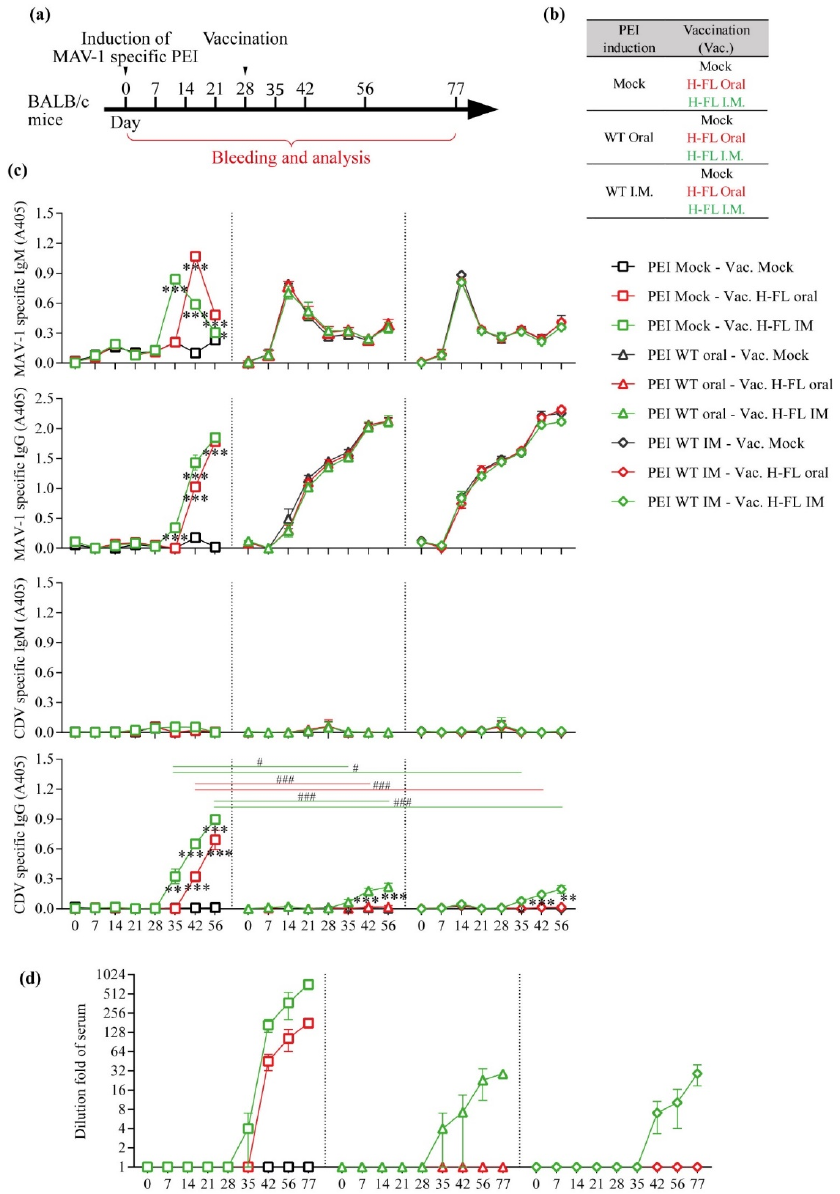
Figure 5. Effect of pre-existing immunity on primary vaccination efficiency. ( a , b ) Design of the experiment. Anti-MAV-1 specific pre-existing immunity was induced in 8-week-old female BALB/c mice ( n = 5 mice/group) through oral or intramuscular infection with 2000 TCID50 of MAV-1 WT as described in the methods. Mice were then immunized, or not, with 2000 TCID50 of the H-FL MAV- 1 strain at day 28 via the oral or the intramuscular route. Blood samples were taken at the indicated time points. ( c ) MAV-1 and CDV specific IgG and IgM measured over time in mouse serum as de- scribed in the methods. The different routes to induce pre-existing immunity are represented by symbols (mock: □ ; oral: △ ; IM: ◇ ) and the different routes of vaccination with the H-FL strain of MAV-1 are labeled by colors (mock: black; oral: red; I.M.: green). The data presented are the means for 5 mice ± SEM. p values represented with stars (*) are relative to comparison with the Vac. mock group. *, p < 0.05, **, p < 0.01, ***, p < 0.001. p values represented with hashtags (#) are relative to comparison with the PEI mock group. #, p < 0.05, ###, p < 0.001. ( d ) CDV-neutralizing antibody titres measured over time in mouse serum as described in the methods. The symbols and color code are identical those of ( c ). The data presented are the means for 5 mice ± SEM.